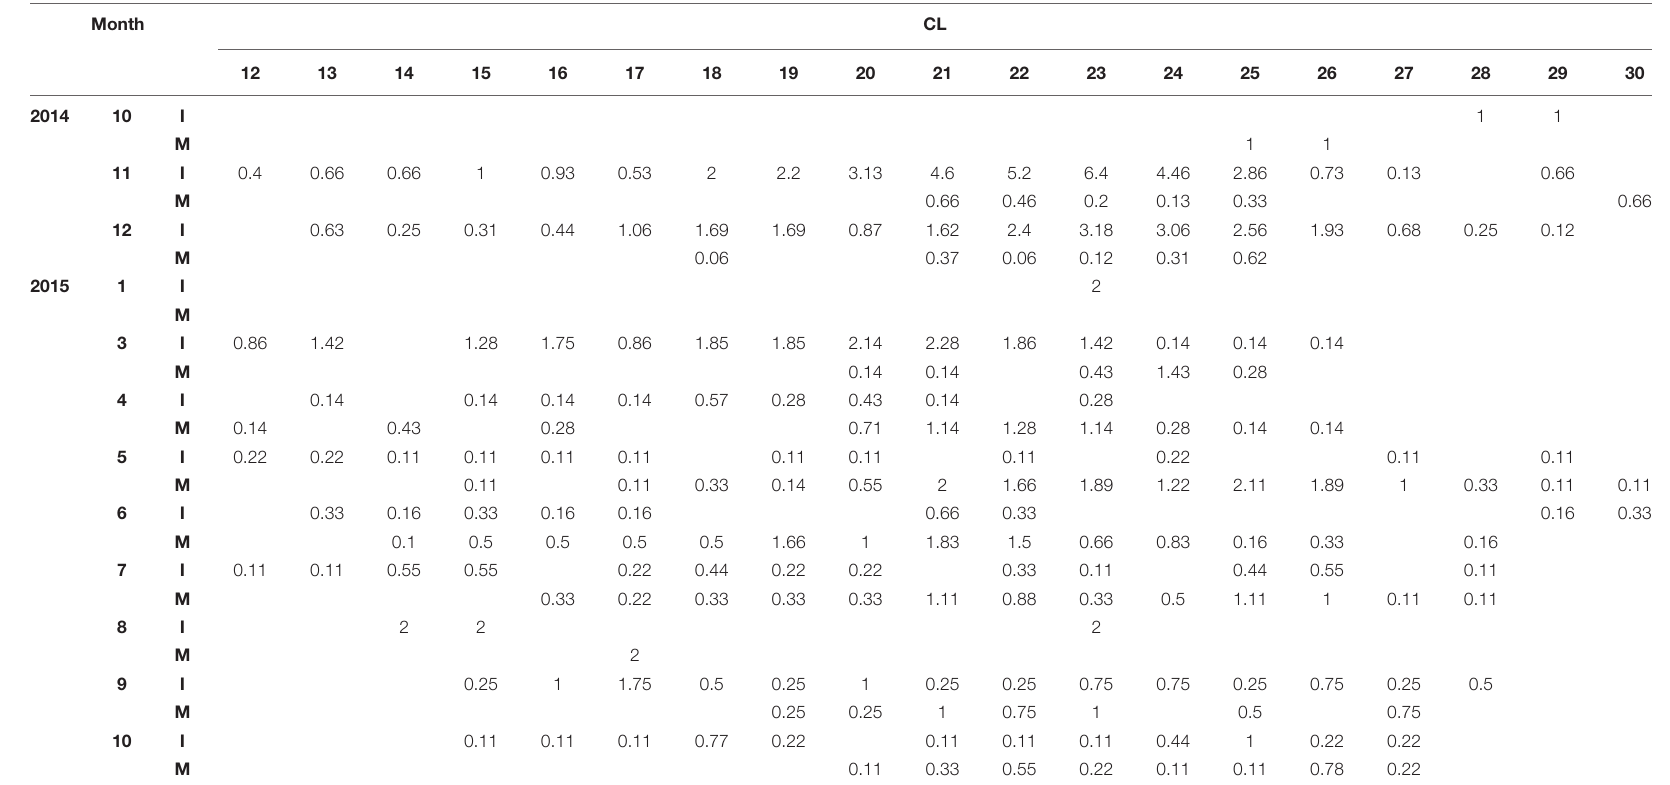
TABLE 2 | Standardized monthly (1: January – 12: December) length frequency of mature and immature females of P. edwardsii in SE Aegean Sea during 2014–2015.